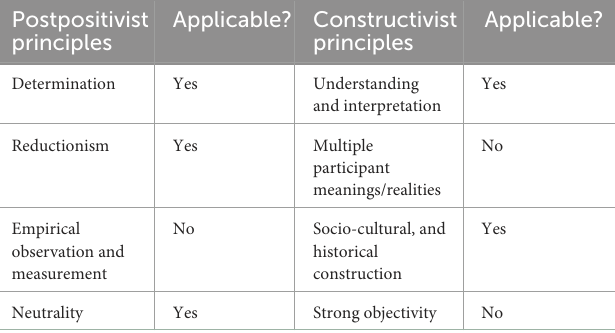
TABLE 2 Breakdown of the postpositivist and constructivist principles applicable to the worldview of this